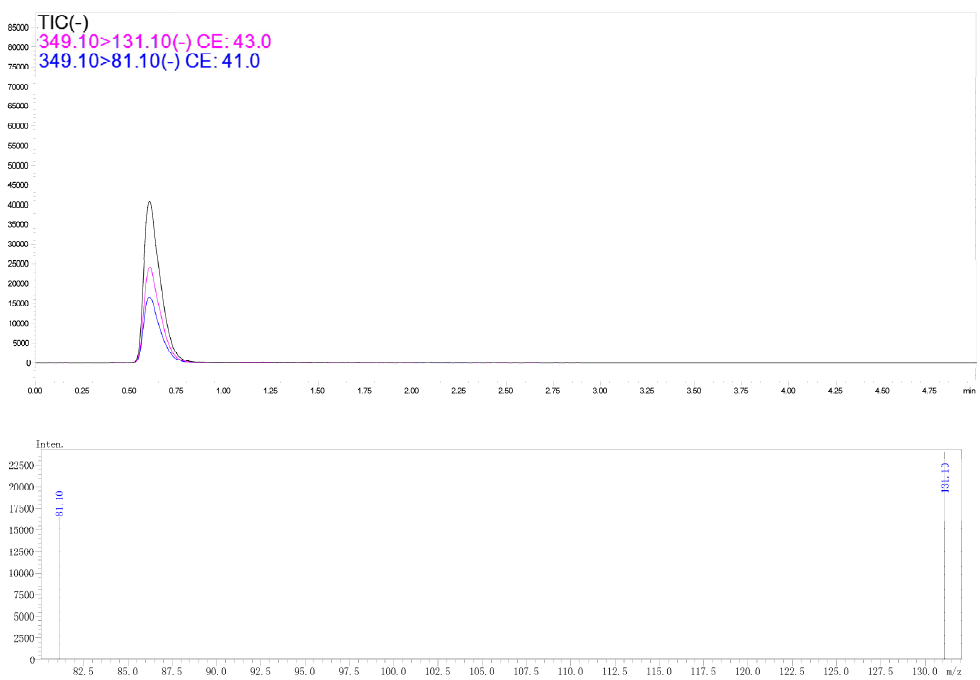
Figure 4. Typical spectra of tralopyril in radish leaf matrix extract detected by UPLC-MS/MS. The concentration of tralopyril was 0.1 mg/L.